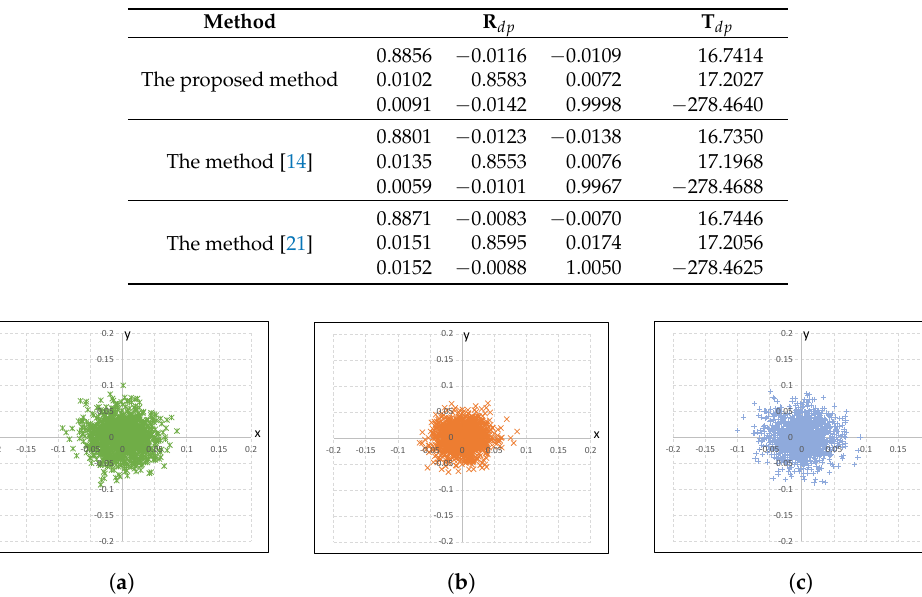
Table 2. Calibration results of the proposed method and existing methods.